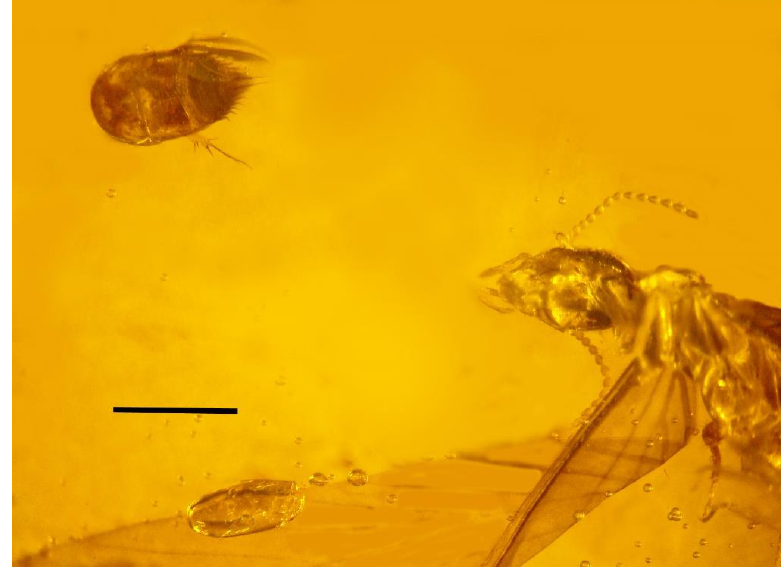
Figure 13. Prorhinopsenius alzadae (Coleoptera: Staphylinidae) adjacent to a termite (Blattodea: Rhinotermitidae) in Dominican amber. Scale bar = 750 µm.